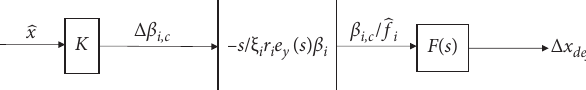
Figure 15: The effect of the reconfiguration on the blades.